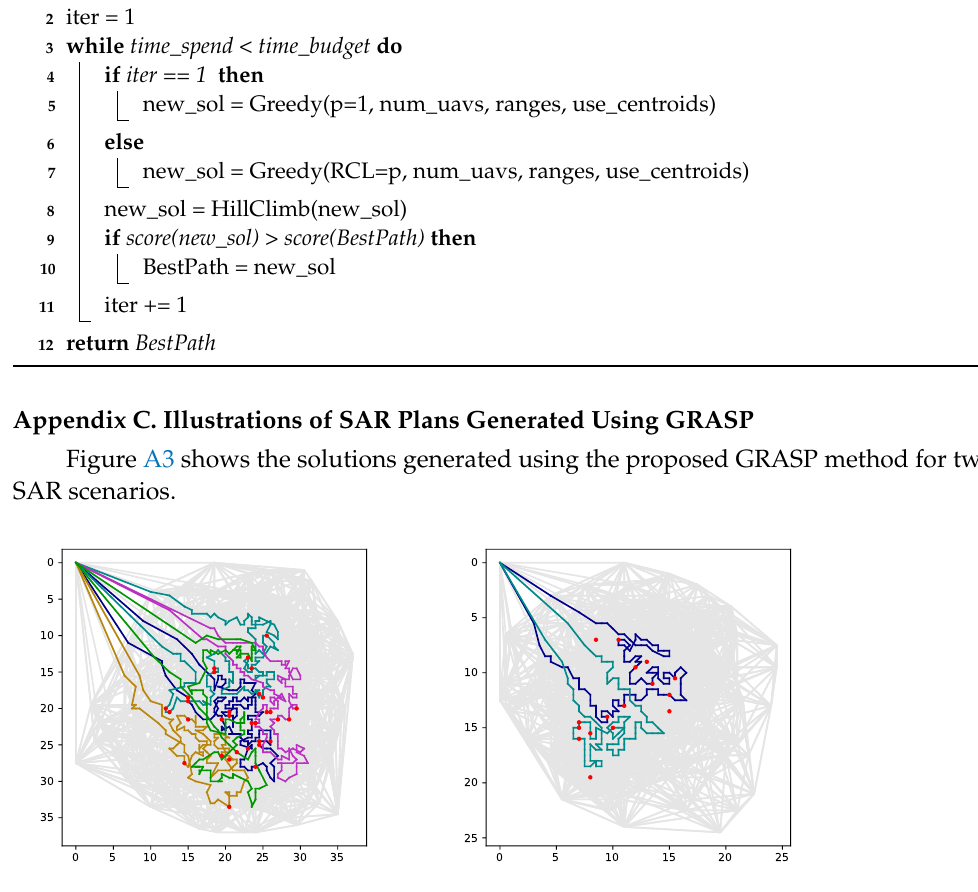
Figure A3. Solution of two instances of the problem using GRASP.